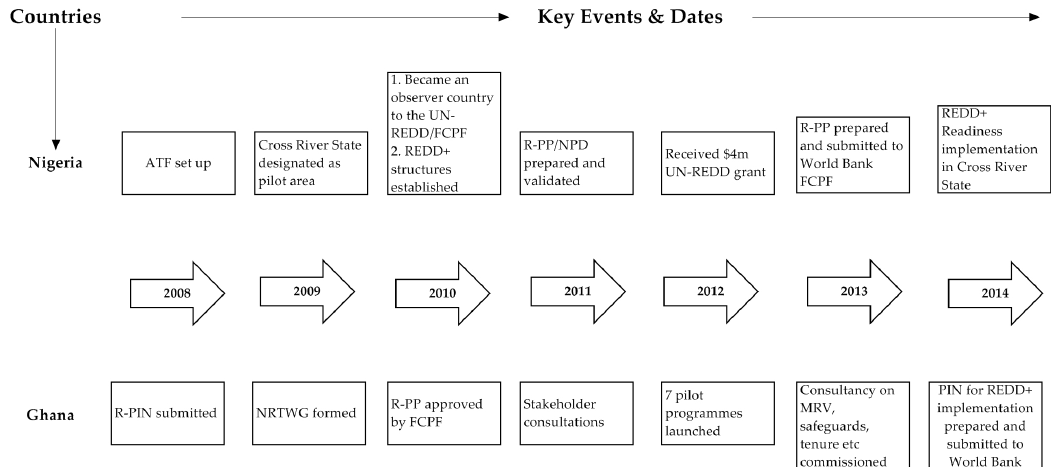
Figure 3. Key timelines for REDD+ in Nigeria and Ghana. ATF: Anti-Deforestation Task Force; UN-REDD: United Nations-Reducing Emission from Deforestation and Degradation; FCPF: Forest Carbon Partnership Facility; R-PP: REDD+ Readiness Programme Proposal; NPD: National Programme Document; R-PIN: REDD+ Project Idea Note; NRTWG: National REDD+ Technical Working Group; MRV: Measurement, Reporting and Verification.